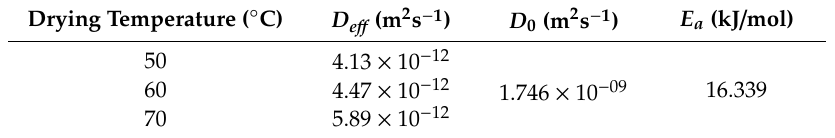
Table 5. D e ff coe ffi cients and E a of linden leaves under di ff erent IR drying temperatures. Table 5. D eff coefficients and Ea of linden leaves under different IR drying temperatures.